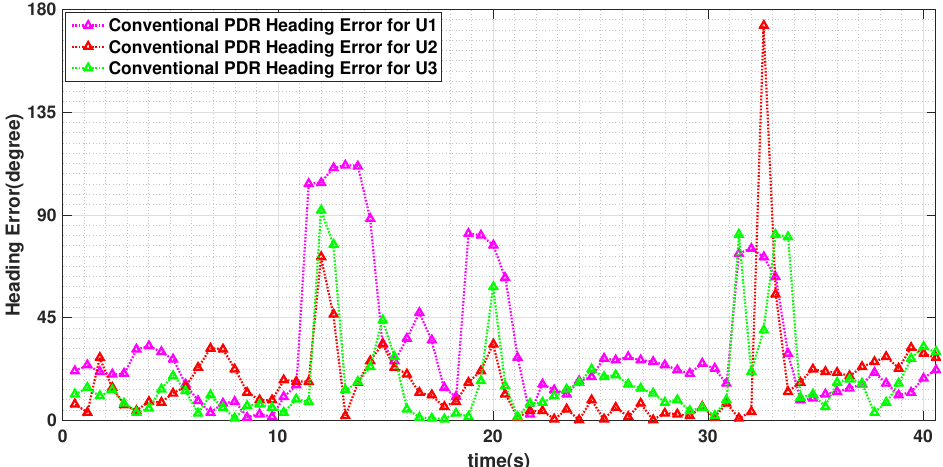
Figure 9. Heading estimates of three users using conventional PDR. The pedestrians walk in different speed and over the square path 3 turns shown in Figure